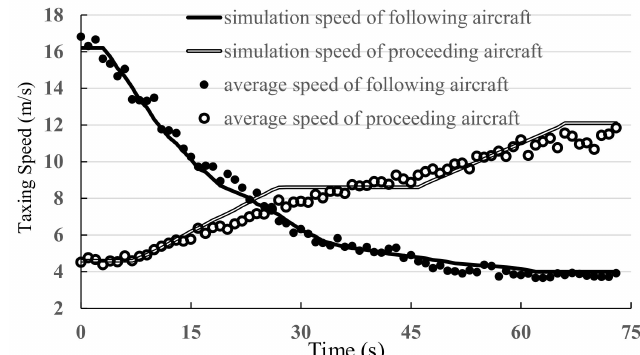
Figure 11. Average Speed of Actual Trajectory and Simulated Trajectory Speed, Proceeding aircraft should be gradually accelerated to the comfortable taxiing speed of v C , and then gradually accelerated to the turning speed limit of v T , so comes the plateau in line of simulation speed of proceeding